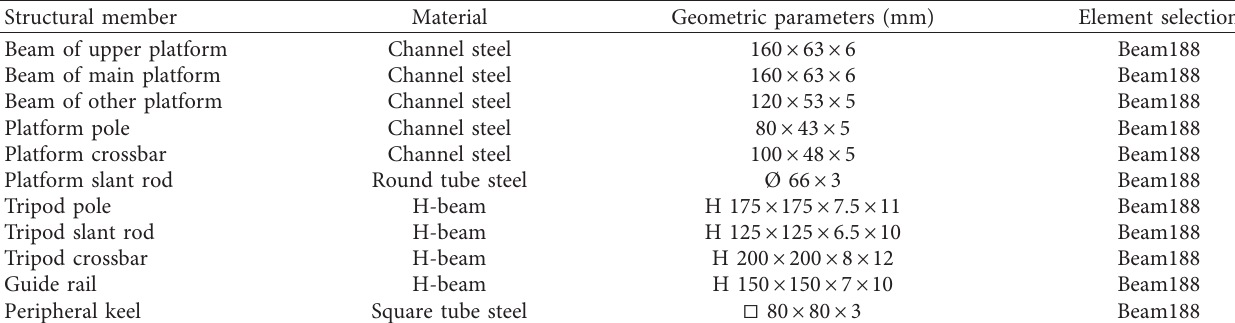
Table 2: Main unit parameters of climbing